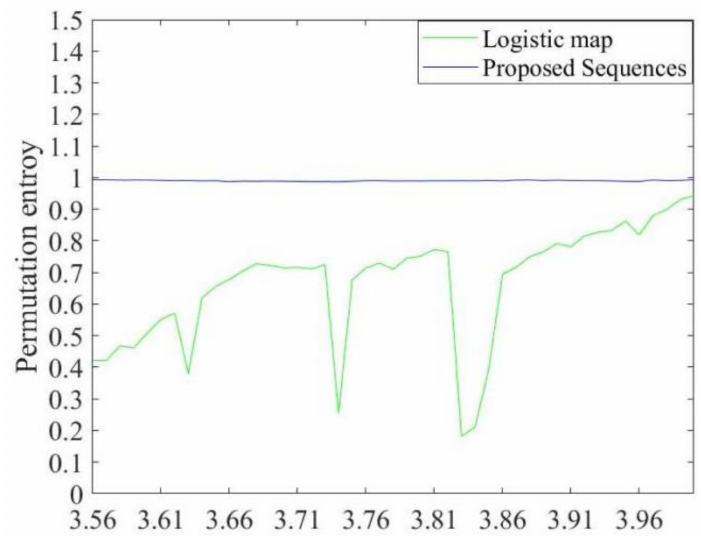
Figure 5. Permutation entropy of x -dimensional proposed sequence and Equation